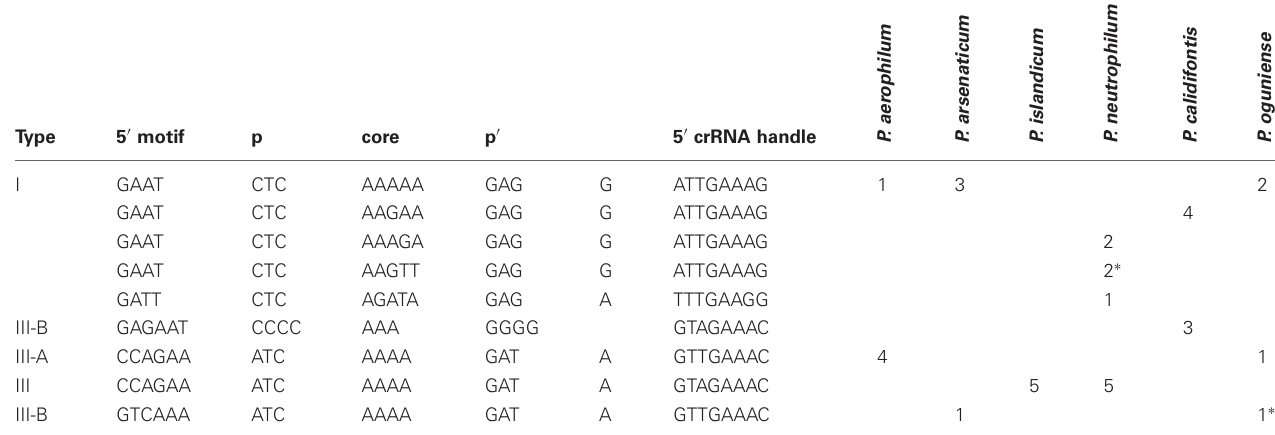
FIGURE 2 | NurA and HerA gene families in Pyrobaculum species. Pyrobaculum species encode at least three nurA-herA gene-pairs, shown above to display parallel phylogenetic structure (left and right panels), with genomically adjacent genes matched by color. Within each gene clade (red, green or blue), the relationship of genes follows the expected species tree, indicating robust ortholog groups. The CRISPR-associated nurA-herA pairs (shown in red above) maintain the paired relationship throughout the Thermoproteales. An unmatched paralogous group of herA genes appears in black. The Vulcanisaeta distributa nurA-herA genes are provided as outgroups of the Pyrobaculum genus; note that only the CRISPR-associated nurA-herA Table 1 | Pyrobaculum direct repeat (DR)